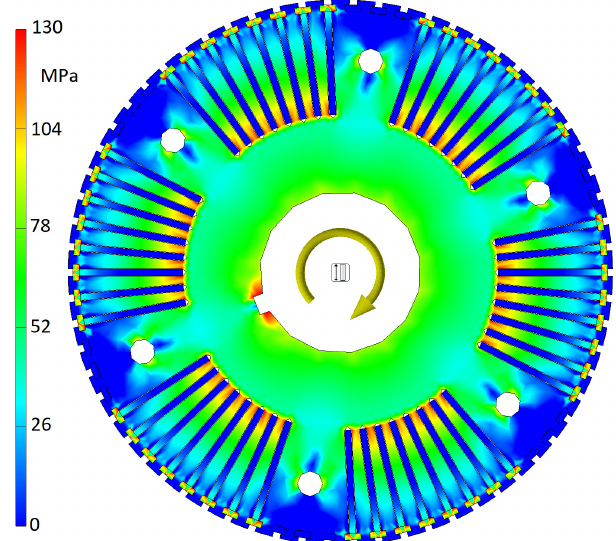
Figure 9. FEM simulation stress analysis results of centrifugal force acting on the